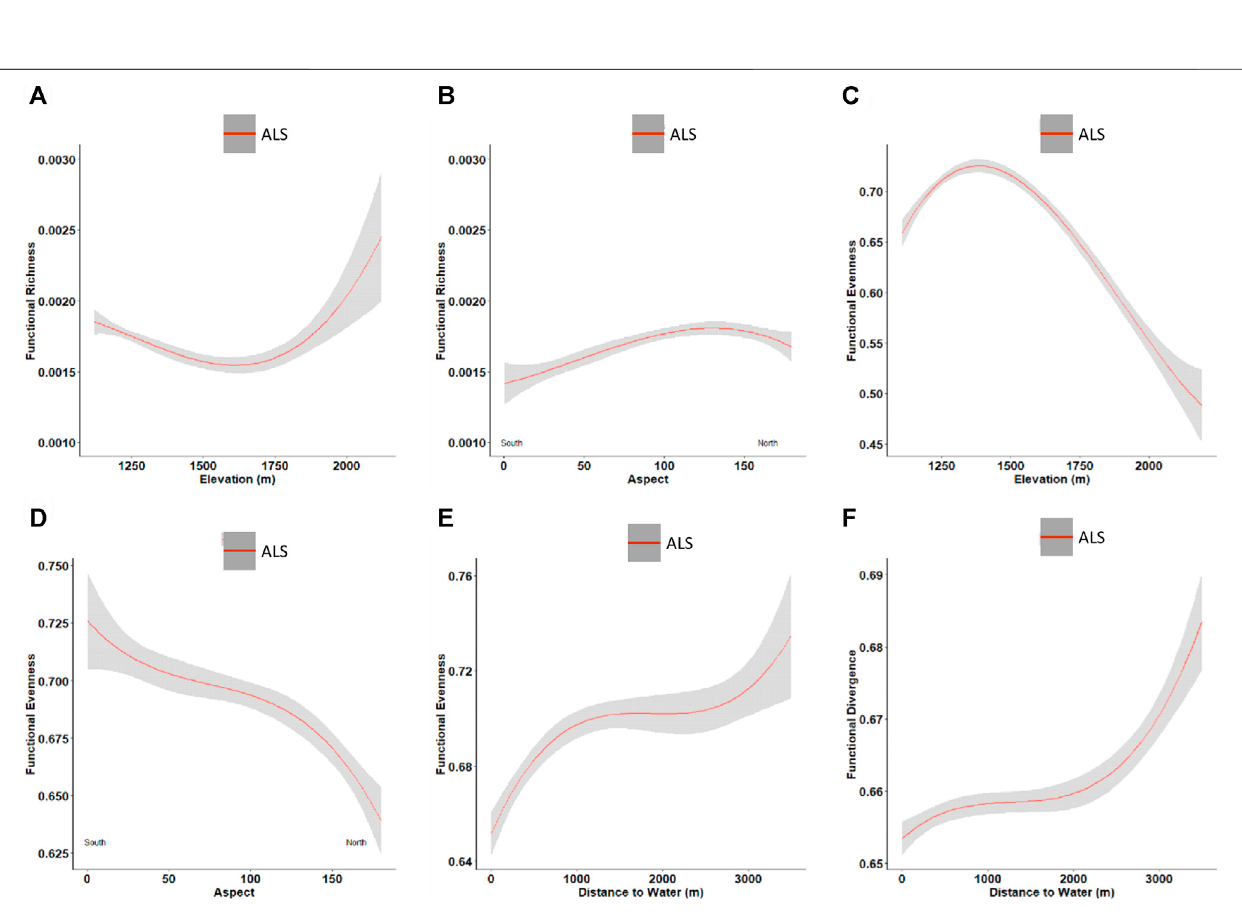
Frontiers in Remote Sensing |